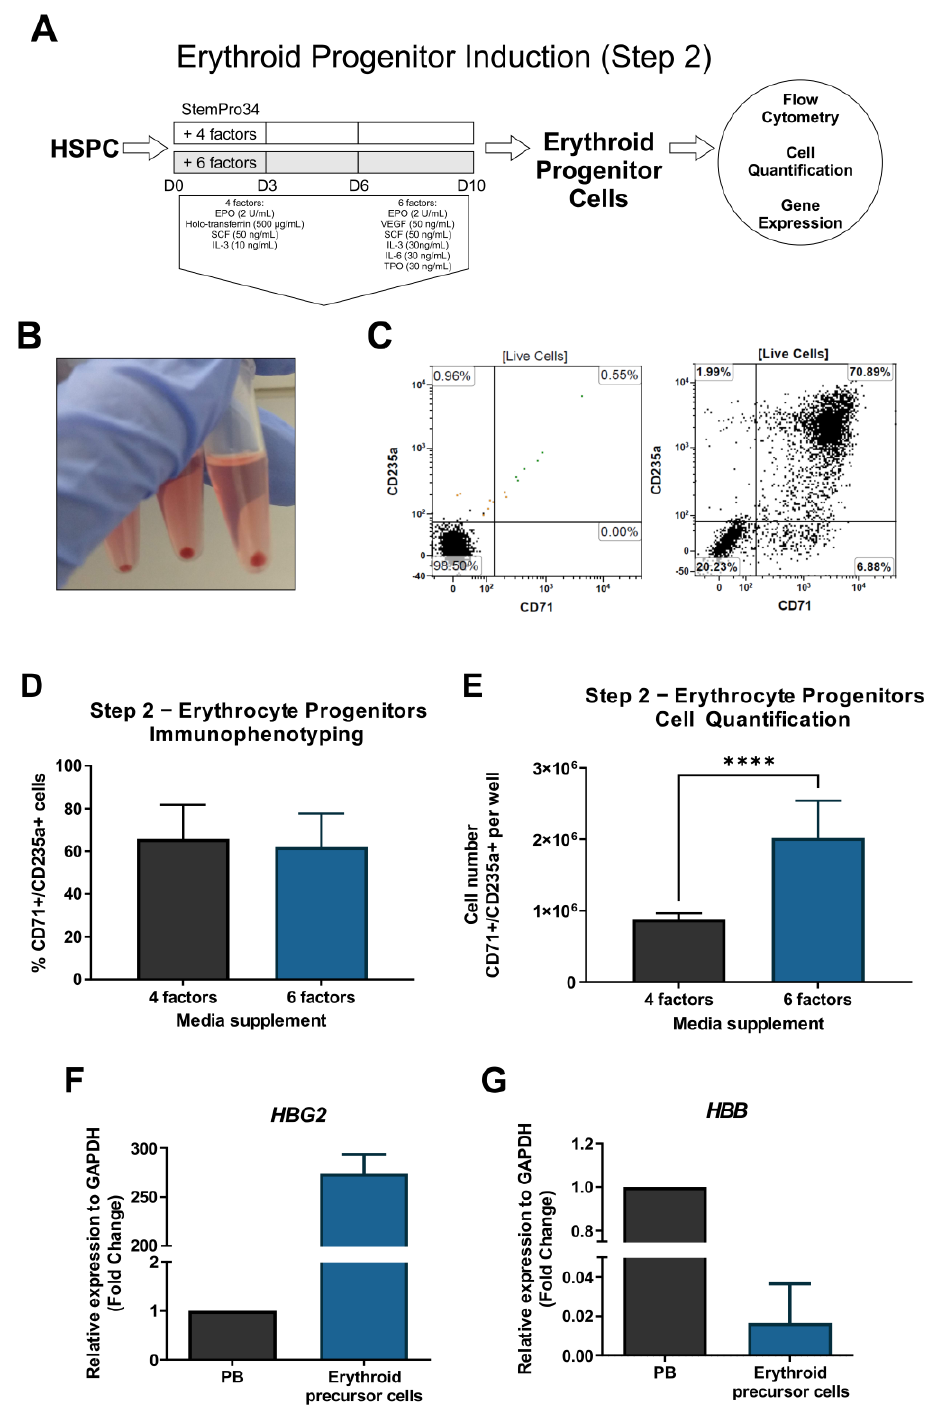
Figure 5. Workflow of Step 2 and analysis of iPS-derived erythroid progenitor cells (EPCs) ( A ). Representative image of red cell pellet observed after centrifugation of Step 2 D10 samples ( B ). Representative flow cytometry dot plot analysis of CD71 and CD235a as markers for EPCs (left: isotype control; right: specific antibodies)( C ), percentage of cells ( D ) and cell quantification ( E ) of the CD71 + /CD235a + subpopulation in SP34+4F and SP34+6F media. Gene expression analysis of HBG2 gene ( F ) and HBB gene ( G ) compared to peripheral blood (PB). **** p < 0.0001.